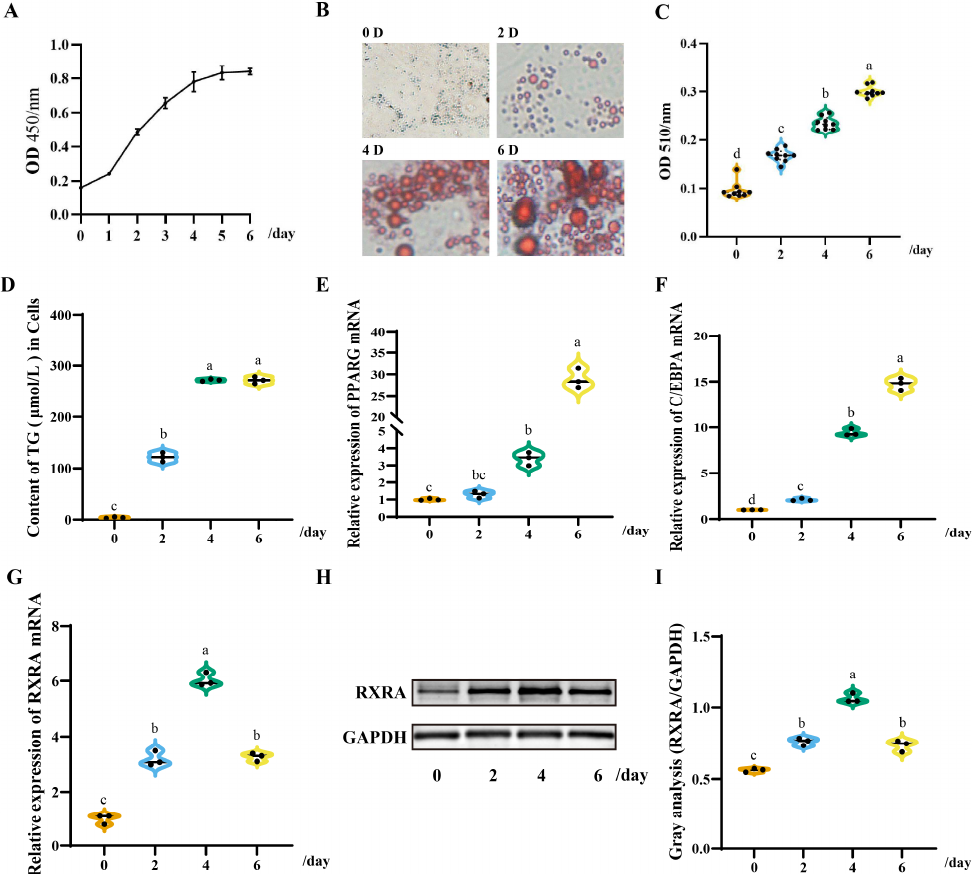
Figure 1. The expression pattern of duck RXRA in the duck preadipocytes (DPACs). ( A ) Multipli- cation curve of the DPACs. ( B ) Fat content of the DPACs induced by the differentiation medium at 0, 2, 4, and 6 days. The images were taken under 200× magnification. ( C ) OD 510/nm: absorbance at 510 nm. ( D ) Triglyceride (TG) content at 0, 2, 4, and 6 days of the induced DPACs. ( E ) The genes expression changes of the induced DAPCs. ( E ) The PPARG gene expression of the induced DAPCs. ( F ) The C/EBPA gene expression of the induced DAPCs. ( G ) The RXRA gene expression of the induced DAPCs. ( H,I ) Changes in RXRA protein expression in the DPACs induced. The data are reported as the mean ± SD on the basis of n = 3 independent experiments. a,b,c,d Significant differences are shown in superscript letters, with different letters representing significant differences ( p < 0.05).